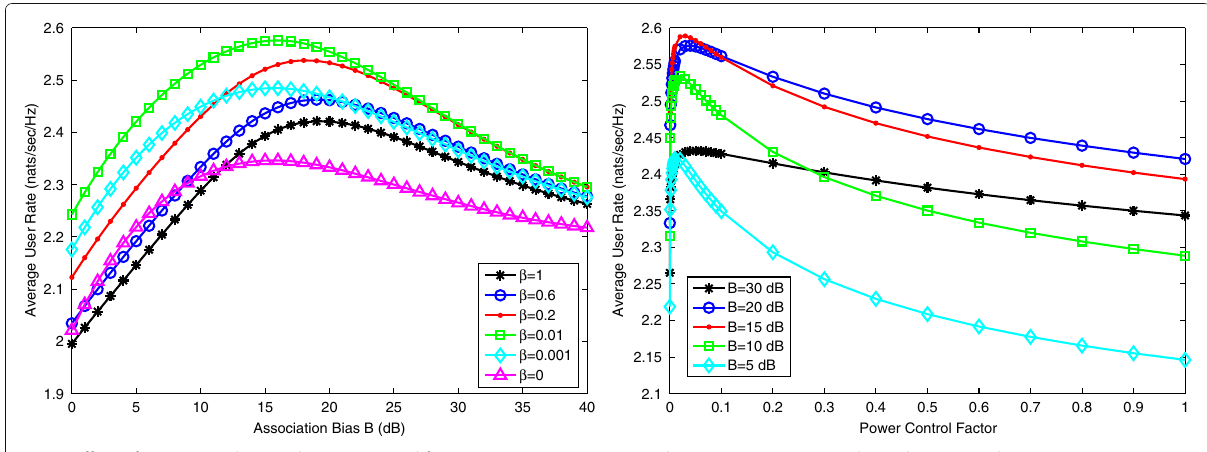
Fig. 8 Effect of association bias and power control factor on average user rate with η = 0.6, T FR,1 = − 20 dB, and T FR,2 = 4 dB